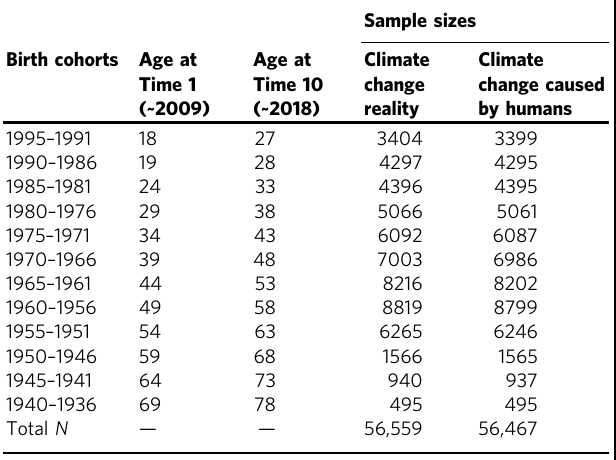
Table 1 Age and sample sizes by birth cohort for each climate change